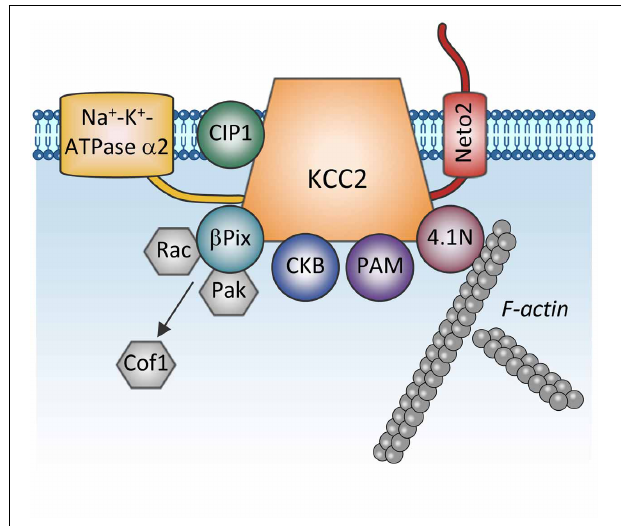
FIGURE 4 | Proteins directly interacting with KCC2. The scheme shows membrane and cytoplasmic proteins that have been found to directly interact with KCC2. It is currently unclear whether these proteins form one big KCC2 containing complex or whether they all are combined in multiple distinct KCC2 containing pools (e.g., plasmalemmal vs. sub-membrane vesicular pools). Na + -K + -ATPase α 2, subunit α 2 of the Na + -K + -ATPase pump ; CIP1, the cation-chloride cotransporter interacting protein 1 ; Neto2, neuropilin and tolloid like-2 ; β Pix, beta isoform of the Rac/Cdc42 guanine nucleotide exchange factor; Rac, small GTPase of the Rho family; Pak, p21-activated serine/threonine-protein kinase kinase; Cof1, cofilin-1; CKB: brain-type creatine kinase; PAM, protein associated with Myc; 4.1N, cytoskeleton-associated